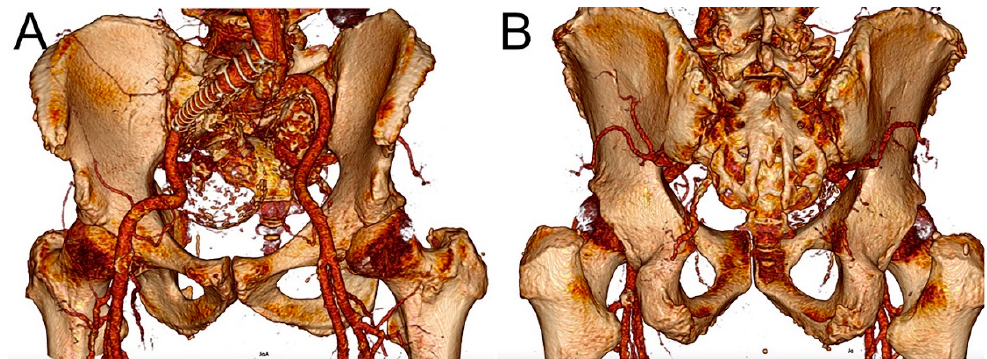
Figure 1. Three-dimensional volume reconstruction of a computed tomography angiography of a patient with type II endoleak to internal iliac artery aneurysm in ( A ) anterior and ( B ) posterior views. The arterial system (including aortic bifurcation, iliac arteries, IIAAs, and superior gluteal